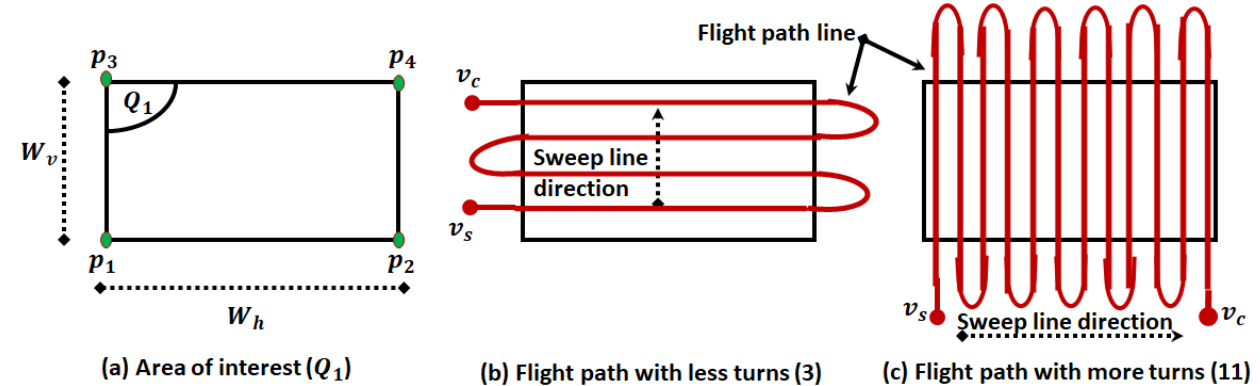
Figure 6. Overview of the coverage path ζ obtained through two alternate sweep